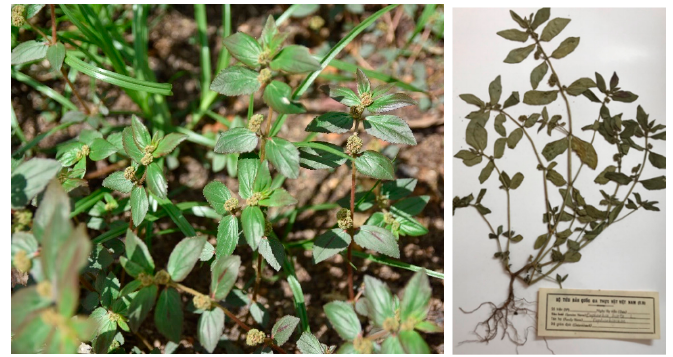
Figure 1. Euphorbia hirta